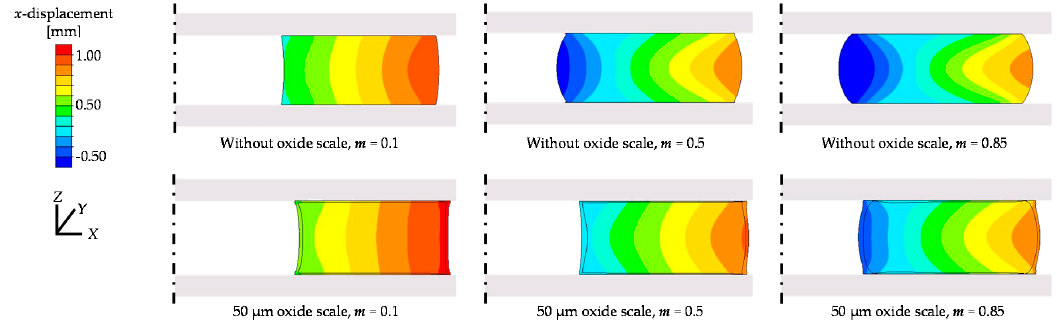
Figure 12. Comparison between numerically-calculated variants with and without oxide scale and varying friction.